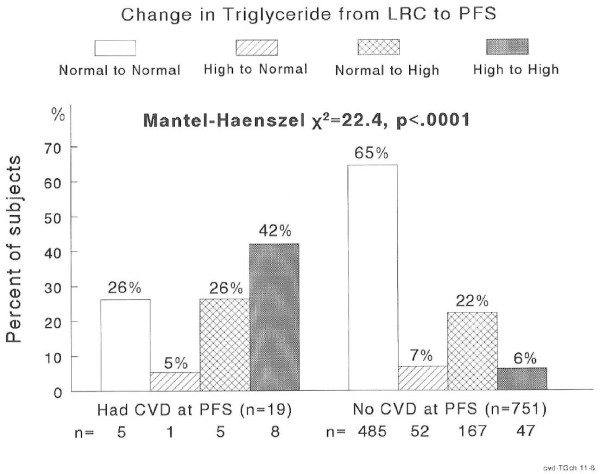
Changes in TG status groups from childhood to adulthood by adult CVD status.